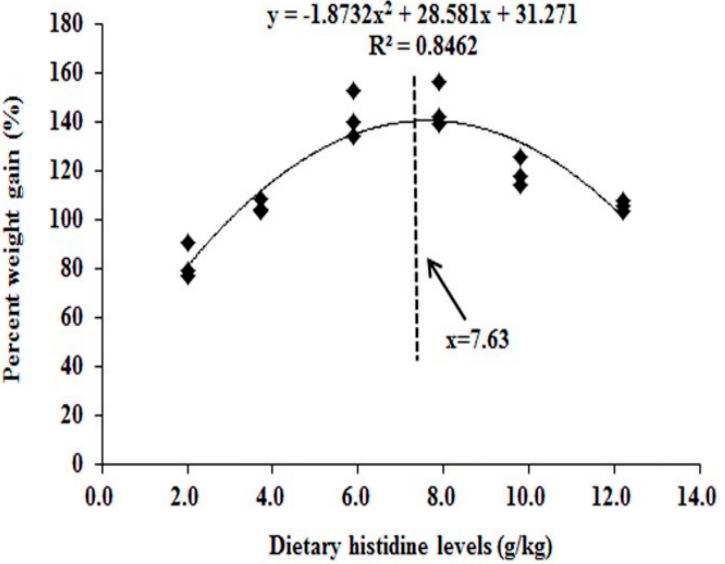
Figure 3. Quadratic regression of the weight gain percentage of grass carp as a function of histidine dose [98].